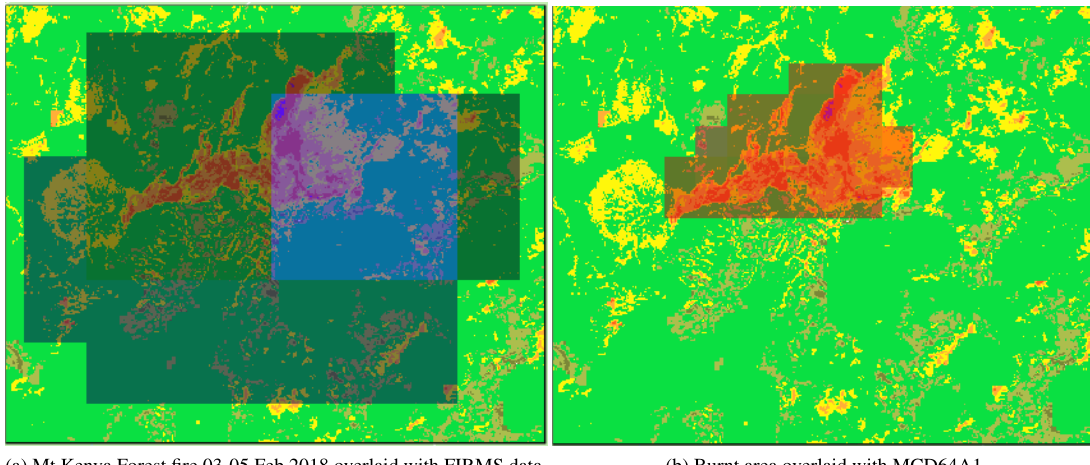
Figure 7. Detected burnt areas in Mt. Kenya overlaid with different